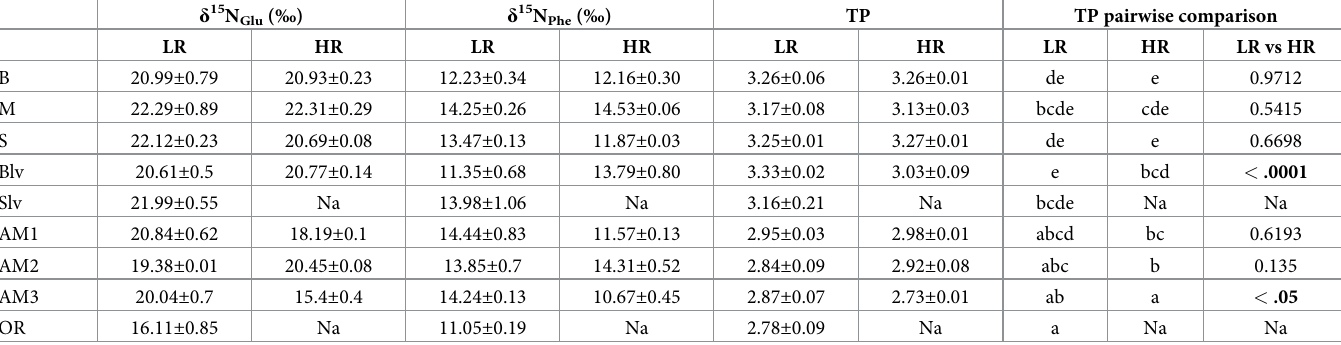
Table 3. δ 15 N Glu , δ 15 N Phe and TP values ( ± SD) during LR and HR regimes. Pairwise comparisons within taxa from the same rainfall conditions and between rainfall periods (in bold significant patterns) for the same taxa are also illustrated. Taxa sharing the same letter do not differ significantly (Tukey’s HSD test, P < 0.05). δ 15 N Glu (‰) δ 15 N Phe (‰) TP pairwise comparison